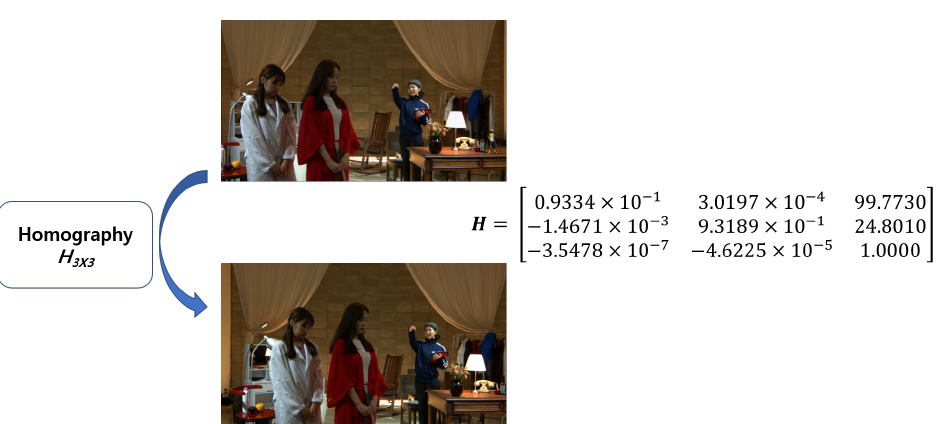
Figure 5. One example of the homography matrix ( H ) estimation. Two images have relative positions, and homography estimation is one of the methods to represent the